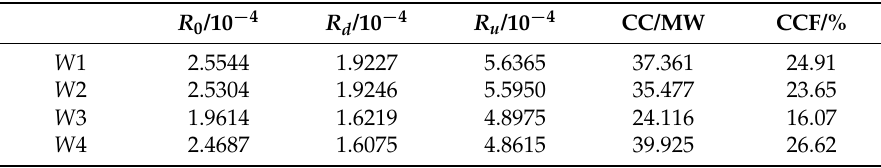
Table 6. Three LOLP values and CC of four wind farms.